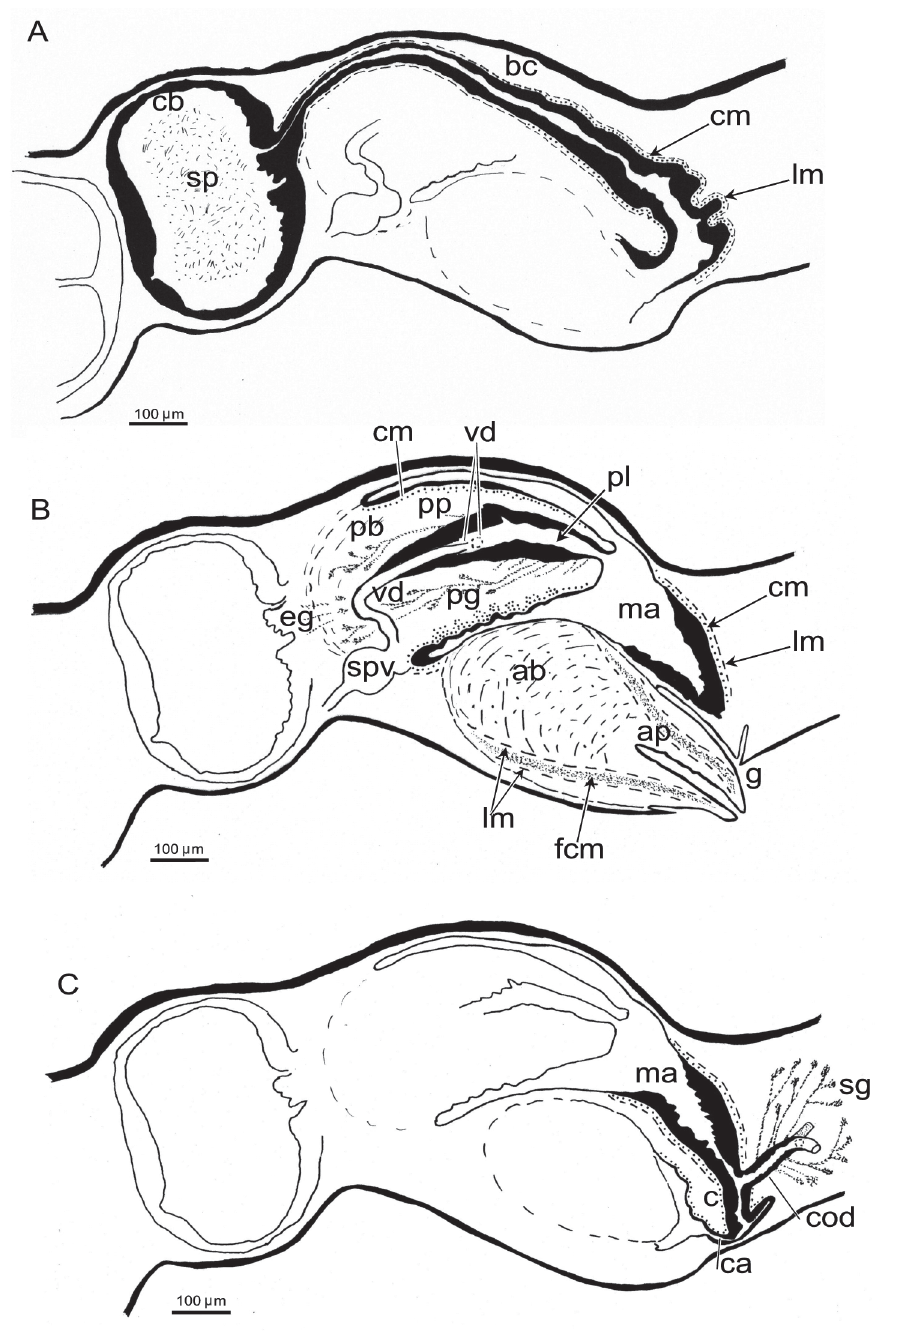
Fig. 3. Dendrocoelum obstinatum Stocchino & Sluys, sp. nov., holotype (ZMA V.Pl. 7264.1). A . Sagittal reconstruction of the female copulatory apparatus (anterior to the left). B . Sagittal reconstruction of the male copulatory apparatus (anterior to the left). Only the terminal portions of the spermiducal vesicles are drawn. C . Sagittal reconstruction of the male copulatory apparatus with the cervix-like protrusion (anterior to the